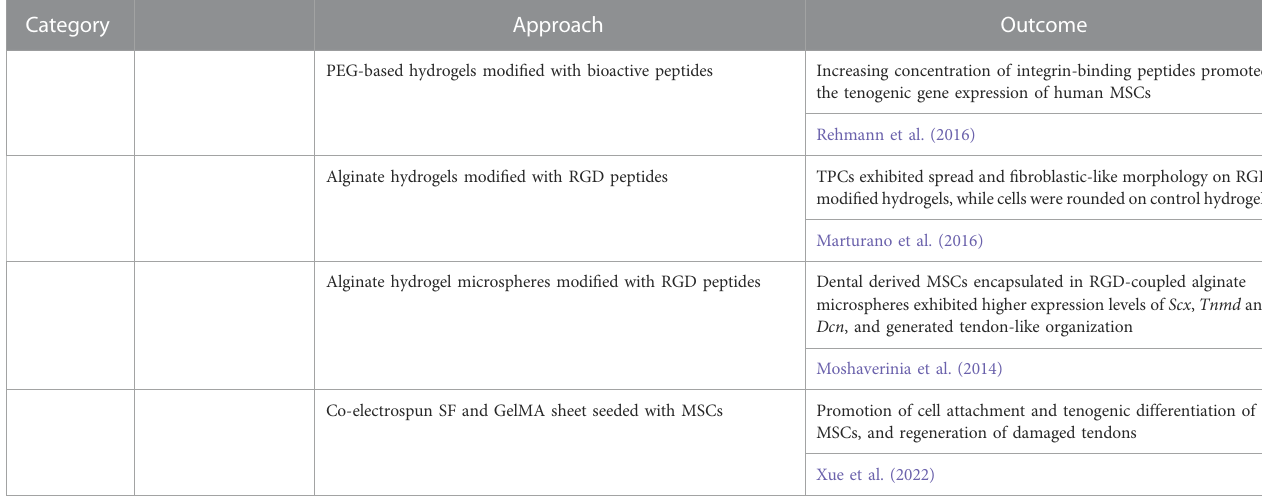
TABLE 2 ( Continued ) Tuning biophysical and biochemical factors of hydrogels for stem cells. Category